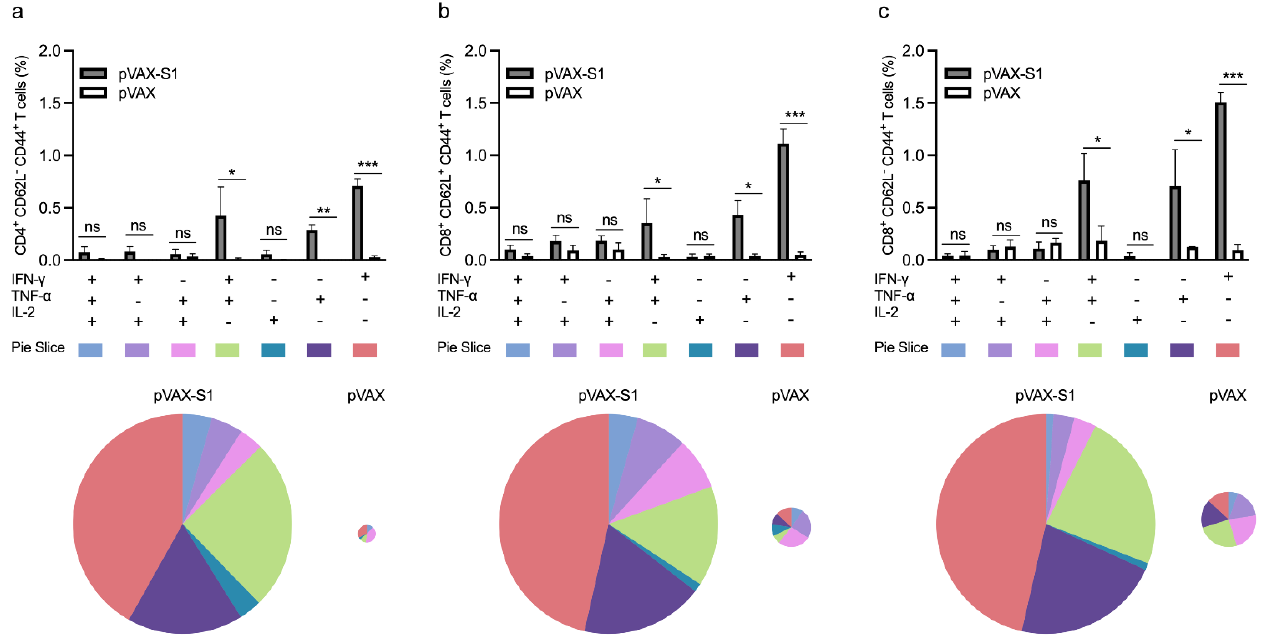
Figure 4. Polyfunctional memory T cell response in immunized mice. Bar graphs represent percentage of single-, double- and triple-cytokine–producing ( a ) memory CD4 (CD4 + CD62L − CD44 + T cells), ( b ) central memory CD8 (CD8 + CD62L + CD44 + T cells) and ( c ) effector memory CD8 (CD8 + CD62L − CD44 + T cells) from samples collected on week 9. Data in histograms are shown as percentages of induced cytokines from peptide-stimulated cells after subtracting levels produced by unstimulated splenocytes from each mouse. Pie charts summarize the various combinations of cytokine-producing cells in each immunization group. Slices are grouped and color coded based on the number of functions. They represent the proportion of each single-, double- and triple-cytokine-producing cell in each subpopulation of ( a ) memory CD4 (CD4 + CD62L − CD44 + T cells), ( b ) central memory CD8 (CD8 + CD62L + CD44 + T cells) and ( c ) effector memory CD8 (CD8 + CD62L − CD44 + T cells) T cells. The size of the pie chart represents the magnitude of the specific influenza virus immune response induced. Data are shown as mean ± SD for each group from one experiment ( n = 3). Statistical significance is reported as *, **, p ≤ 0.01, p ≤ 0.05, ***, p ≤ 0.001, and ns, not significant.